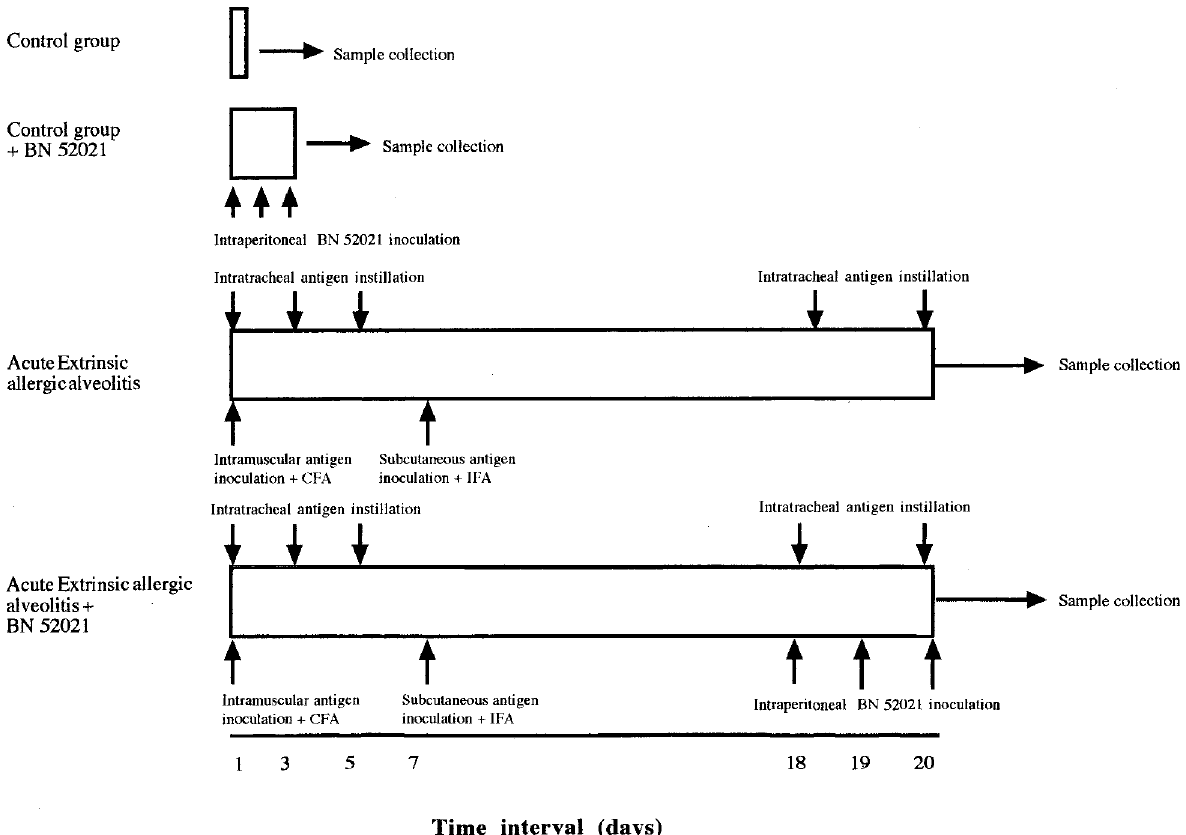
FIG. 1. Experimental protocol. CFA: Complete Freund adjuvant; IFA: Incomplete Freund